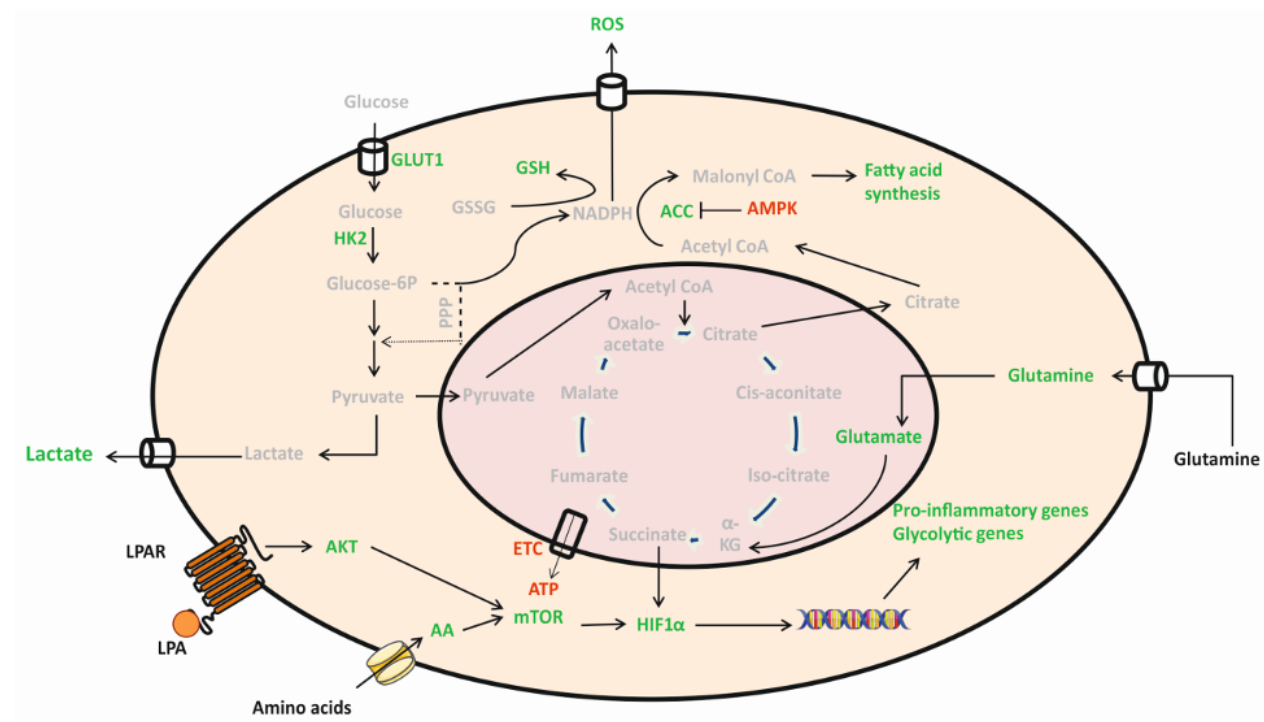
Figure 8. Key metabolic pathways alterations in LPA-activated BV-2 microglia. Graphical summary of findings obtained during this study. Stimulation of microglia with LPA reprograms metabolism towards aerobic glycolysis for generation of ATP via the Akt/mTOR/HIF1 α axis. As a consequence, lactate secretion increases. The activated BV-2 cells switch mitochondrial metabolism to support FA synthesis. Increased AA uptake can further fuel this metabolic program and sustain proinflammatory cytokine synthesis. In response to ROS generation the antioxidant response is initiated and results in higher levels of intracellular GSH to prevent damage of endogenous macromolecules. Red = decreased, green = increased. (Intermediates not experimentally addressed during the present study are shown in grey).